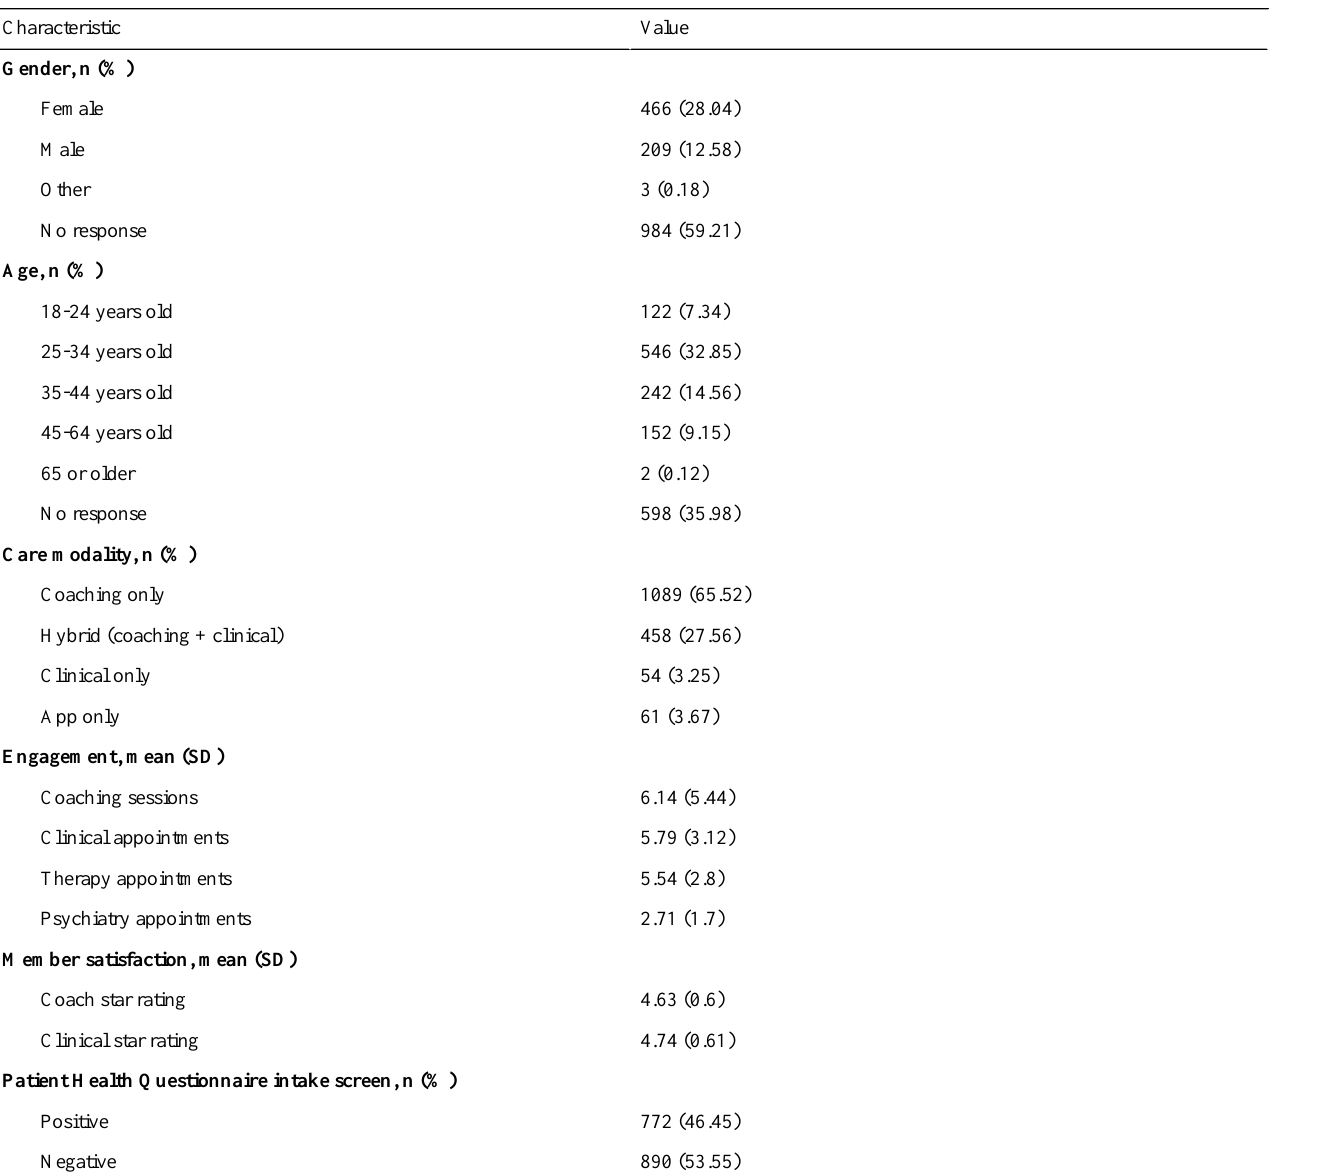
Table 1. Characteristics of the study cohort.